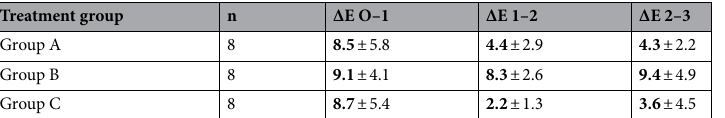
Table 1. Mean color differences and standard deviations of treatment groups between each reading. Ref. ∆E: Color difference— No significant differences were found between the three groups and within each group, between readings.